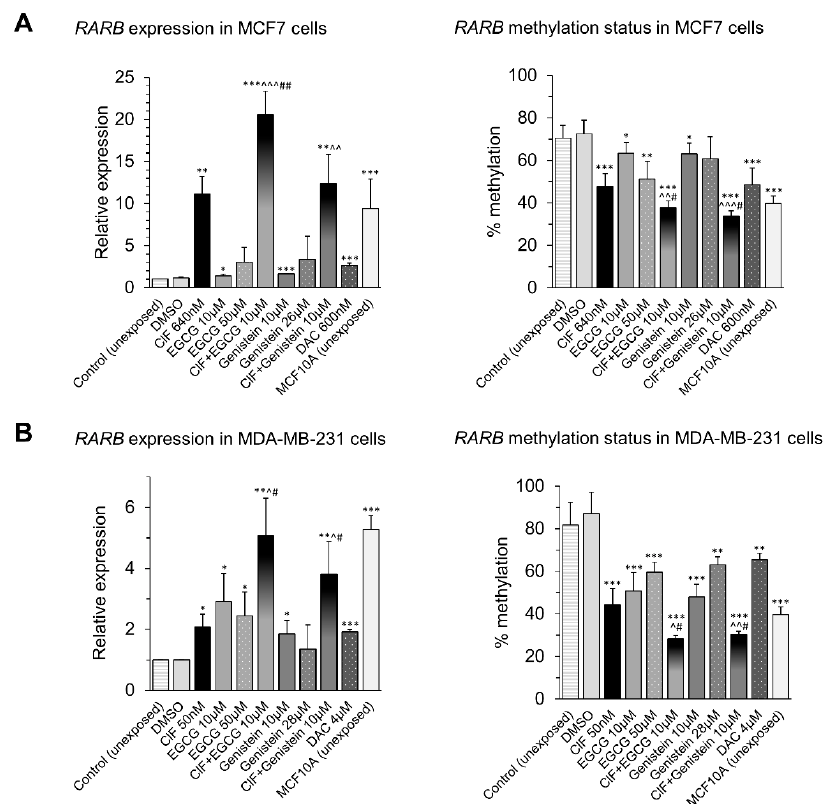
Figure 4. Effects of ClF (IC 50 ) and EGCG (10 µM) or genistein (10 µM) alone and in combination on expression (left panel) and methylation (right panel) of RARB tumor suppressor gene in MCF7 ( A ) and MDA-MB-231 ( B ) cells. All results represent mean ± SD of three independent experiments. Exposure (ClF alone, EGCG alone, genistein alone, ClF + EGCG or ClF + Genistein) versus vehicle control, *** p < 0.001, ** p < 0.01, * p < 0.05. EGCG or genistein alone versus combinatorial exposure (ClF + EGCG or ClF + Genistein), ^^^ p < 0.001, ^^ p < 0.01, ^ p < 0.05. ClF alone versus combinatorial exposure (ClF + EGCG or ClF + Genistein), ## p < 0.01, # p < 0.05.